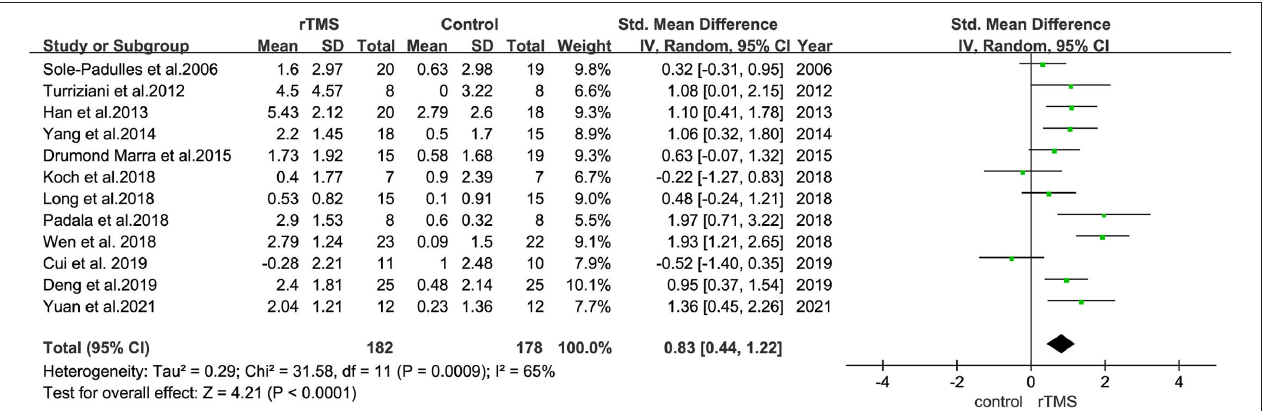
0.73, 95% CI 0.48–0.97, = =